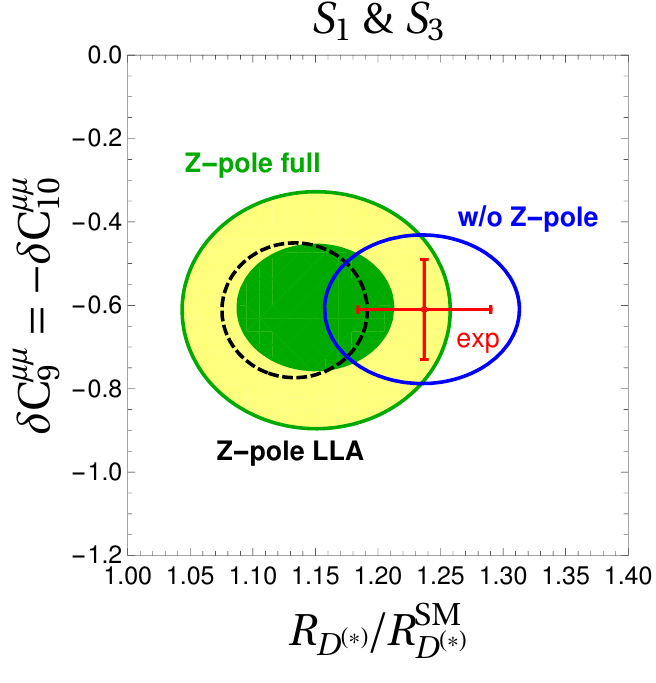
Figure 4 . Results of the low-energy (cid:12)t considering the full expressions computed in this paper are depicted in the plane R =R SM vs. (cid:14)C (cid:22)(cid:22) = C (cid:22)(cid:22) by the green (yellow) regions to 1 (cid:27) (2 (cid:27) ) D ( (cid:3) ) 9 10 D ( (cid:3) ) (cid:0) accuracy. Leptoquark masses are (cid:12)xed to m S = m S = 2 TeV and Yukawa couplings are scanned 1 3 over the ranges described in the text. In the same plot we show the 1 (cid:27) results of the (cid:12)t by neglecting Z -pole constraints (blue line) and by including Z -poles observables with a leading-log approximation (black dashed line) [19{21]. As discussed in the text, the inclusion of (cid:12)nite terms reduces the tension between R exp and Z -pole D ( (cid:3) )